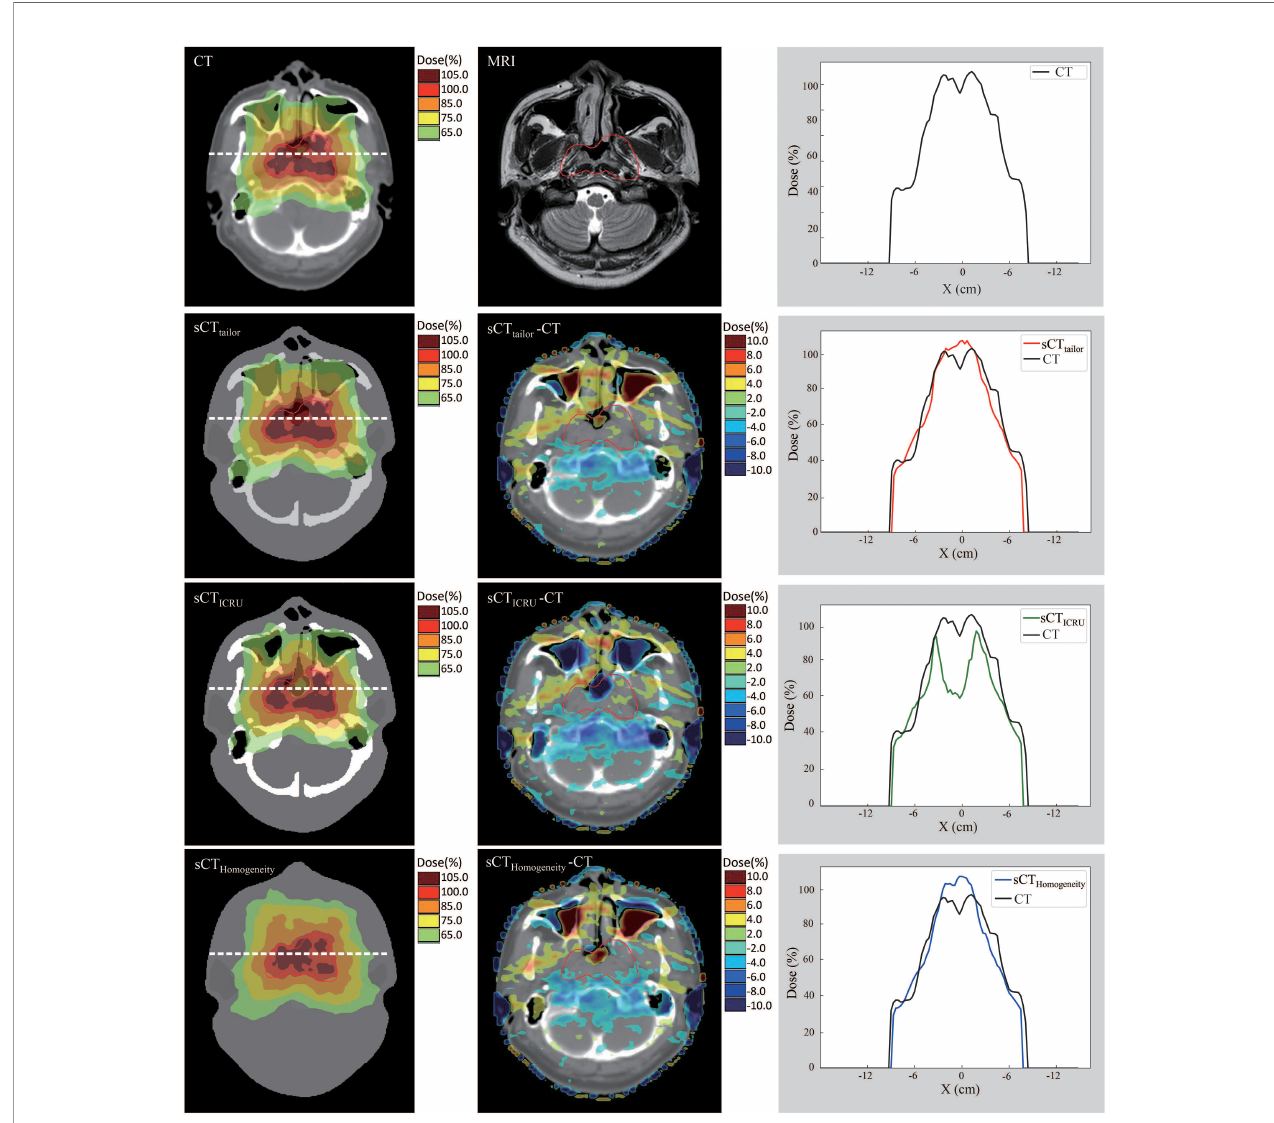
FIGURE 4 | Dose comparison of plans on sCT tailor , sCT ICRU , and sCT Homogeneity with respect to the original CT for dose difference maps and line pro fi le for one NPC